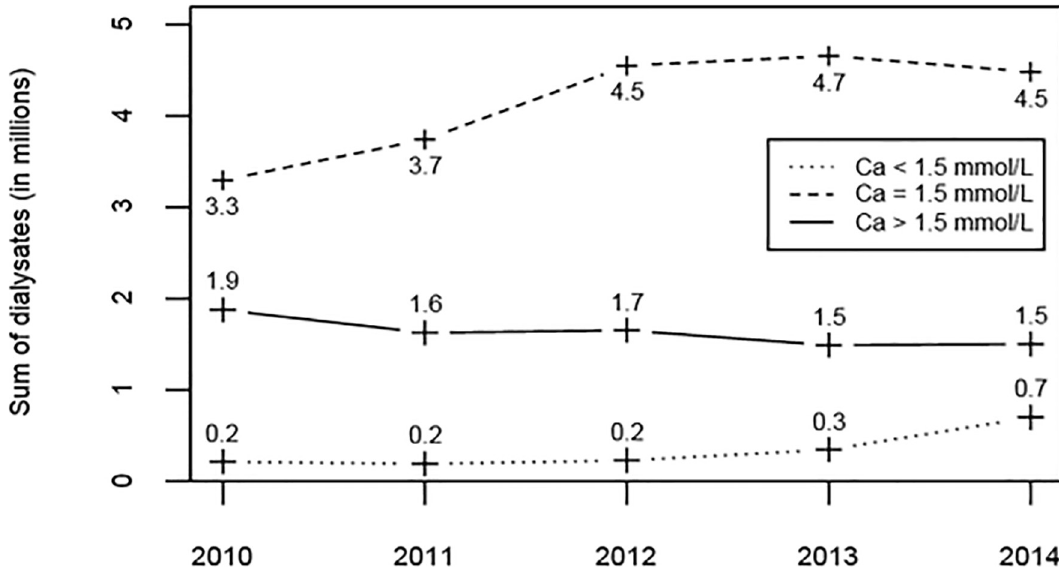
Fig 2. Overall sales of dialysate in France from 2010 to 2014, as a function of the calcium concentration.